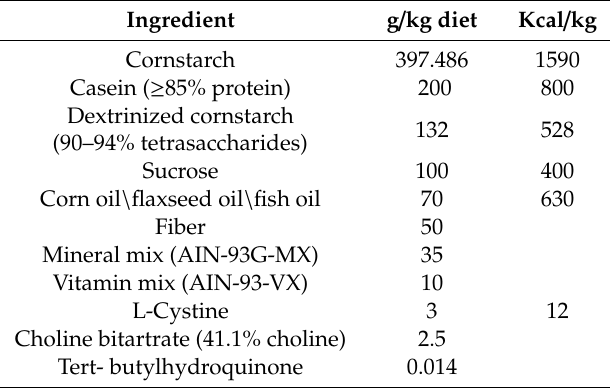
Table 1. Macronutrient and mineral composition of the three experimental diets. Ingredient g / kg